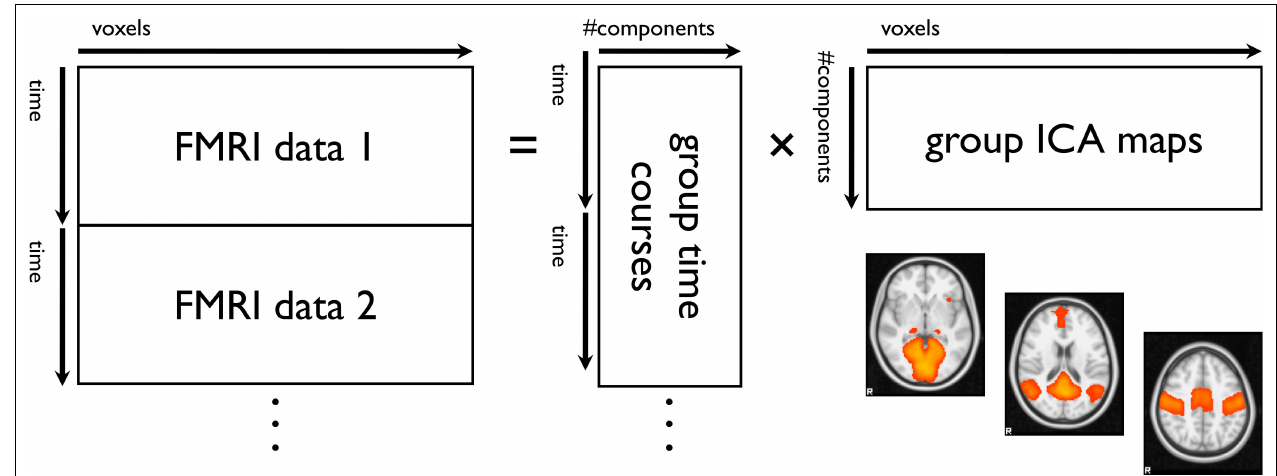
FIGURE 3 | Schematic for temporal concatenation